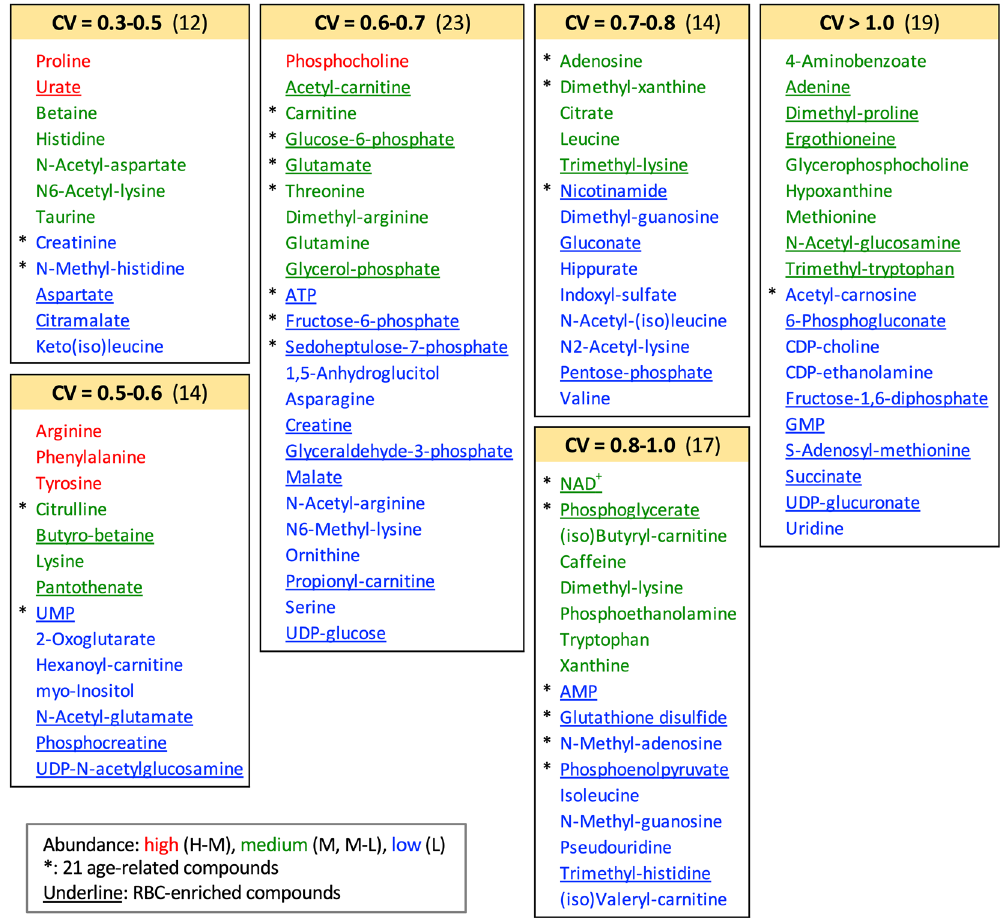
Figure 2. Coefficients of variation (CVs) of 99 salivary metabolites in 27 people from Onna Village, Okinawa. Compounds were classified into 6 sub-groups according to their CVs, as explained in Chaleckis et al. 3 . Numbers of compounds belonging to subgroups are shown in parentheses. Abundances of compounds are semi-quantitatively indicated by their peak areas. In blood, compounds underlined are enriched in RBCs. Compounds shown with asterisks are age-related in